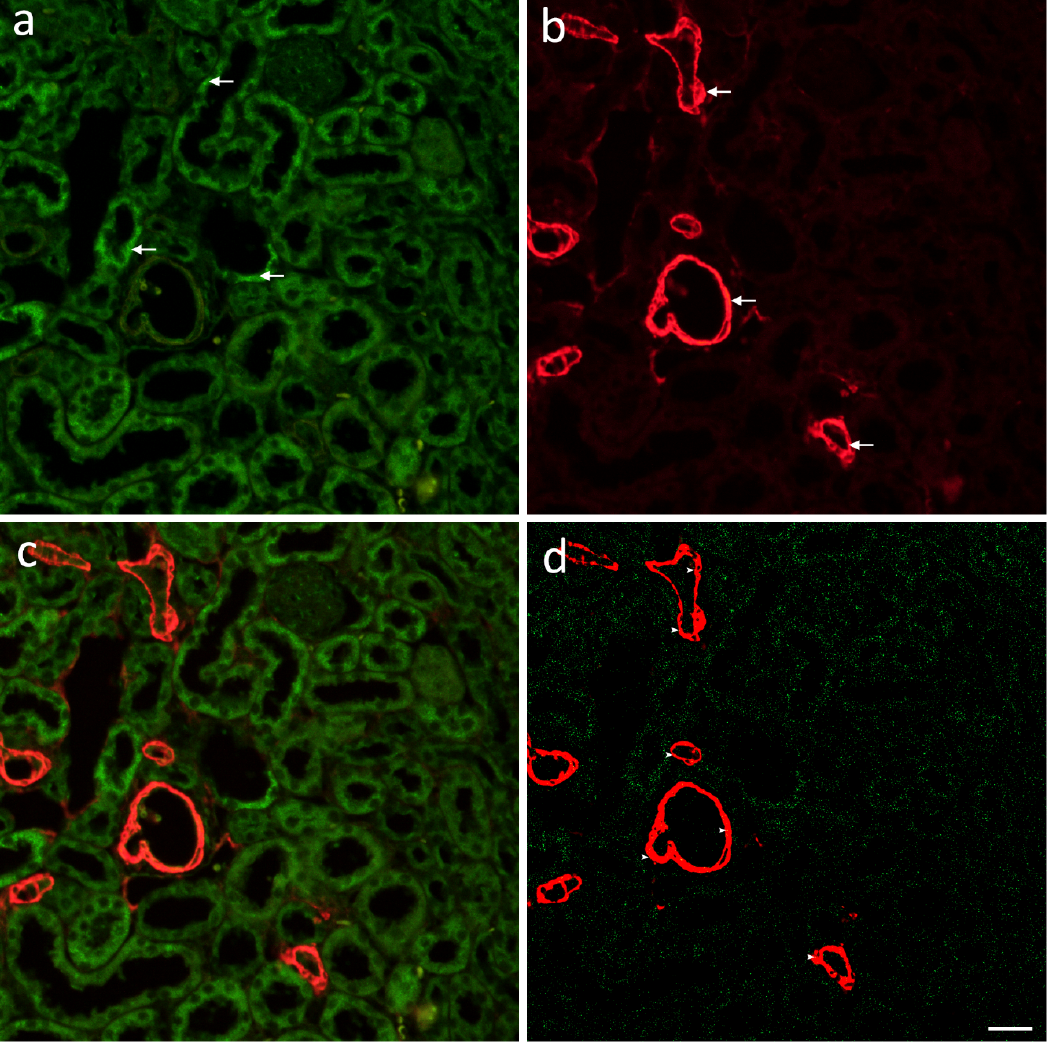
Figure 10. Immunofluorescence staining of postnatal yotari and wild type mouse kidneys with the Cx40 and aSMA markers. Positive signals (arrows) are shown on the green ( a ) and red ( b ) filter. Merged images ( c ) and isolated green and red thresholded signal ( d ) for better quantification of the section percentage area covered by positive signal and the co-localization with aSMA seen as yellow pixels (arrowheads). Scale bar is 20 μ m, refers to all images.